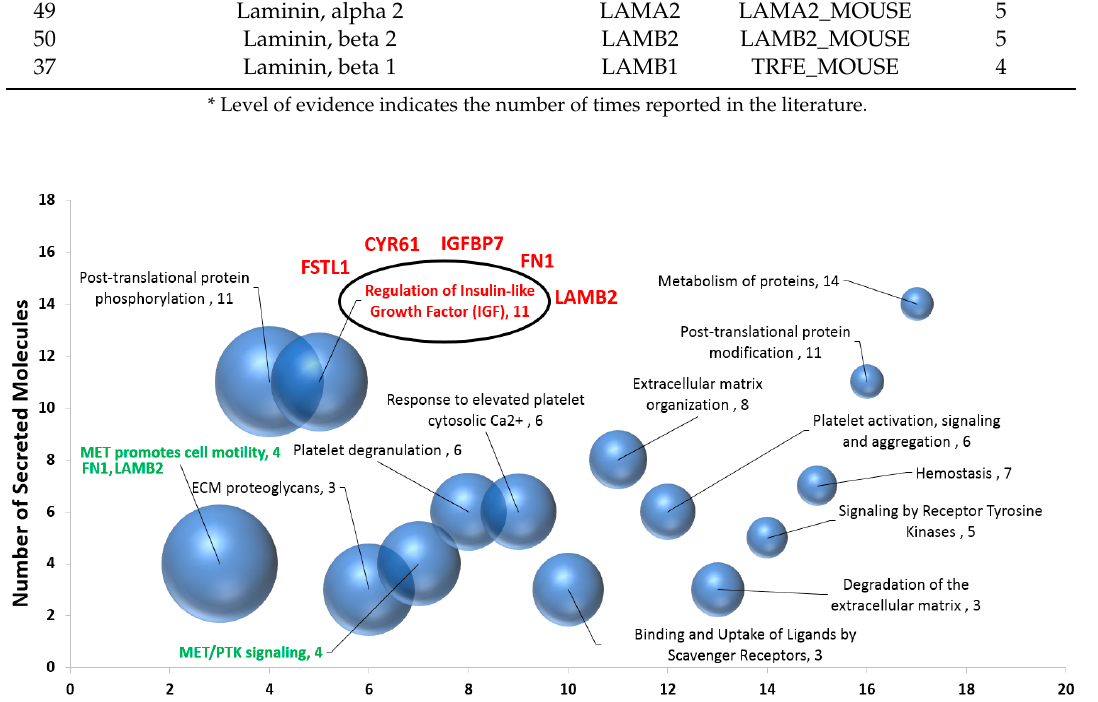
Figure 3. Pathway enrichment of newly secreted proteins detected in co-cultured MSCs at day 1. Fifty-seven newly detected secreted proteins in the conditioned media of differentiating MSCs were categorized by their predicted pathways (X-axis). In the bubble chart, the Y-axis represents the number of proteins involved in each pathway, and the size of the sphere represents the enrichment fold calculated by the Fisher’s exact test ( p < 0.05). PANTHER software was utilized for this analysis (http://www.pantherdb.org/). Proteins in green are related to the mesenchymal epithelial transition pathway (MET), and proteins in red are members of the insulin-like growth factor (IGF) pathway. Fibronectin 1(FN1) and laminin, beta 2 (LAMB2) belong to both pathways.